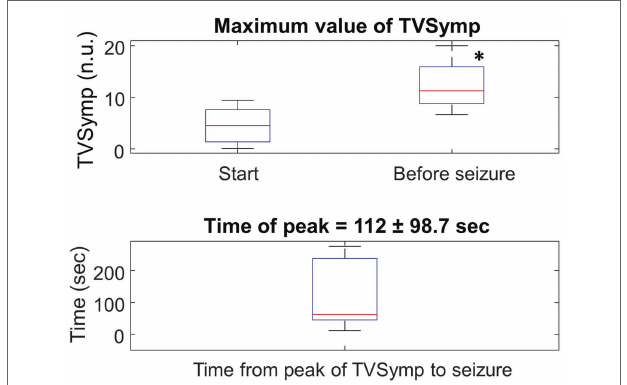
FIGURE 11 | Top: Boxplot for the maximum value of TVSymp at the Start (chamber pressurized) and Before seizure for the entire population. N = 10, * represents significance difference to Start of HBO 2 ( p = 0.005). Bottom: Boxplot of the time-lapse from the peak of TVSymp to the occurrence of the